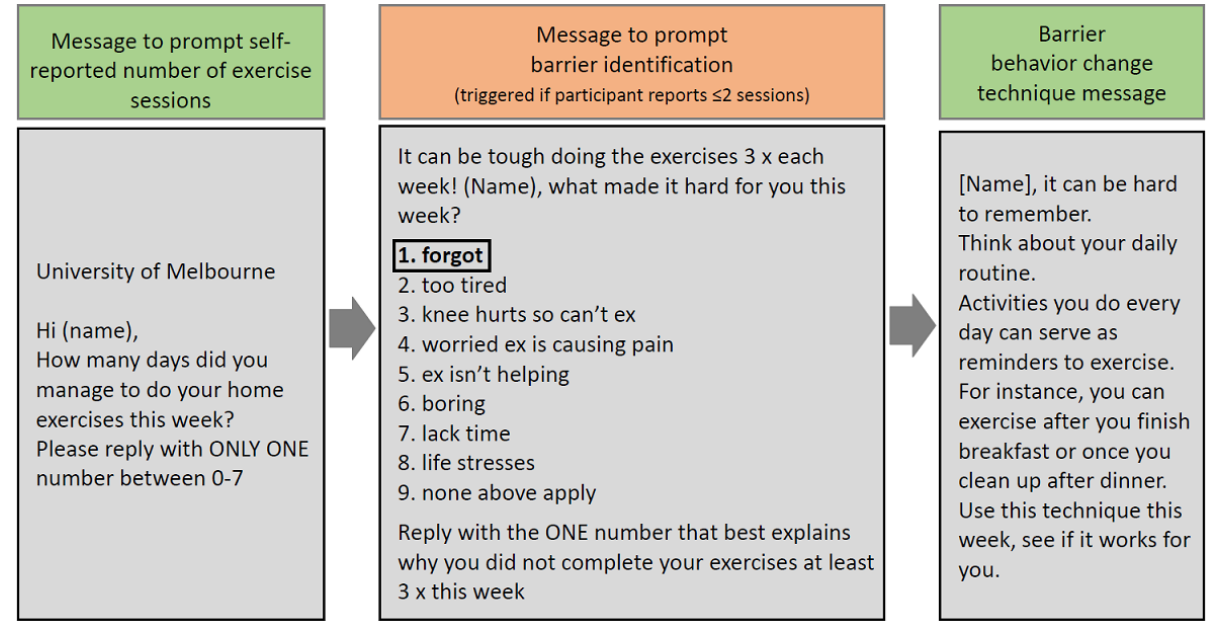
Figure 1. Example automated message sequence for a person with low exercise adherence and reporting their main barrier to exercise as “forgot.” Modified from the study by Nelligan et al 2019. Reproduced under the terms of the Creative Commons Attribution 4.0